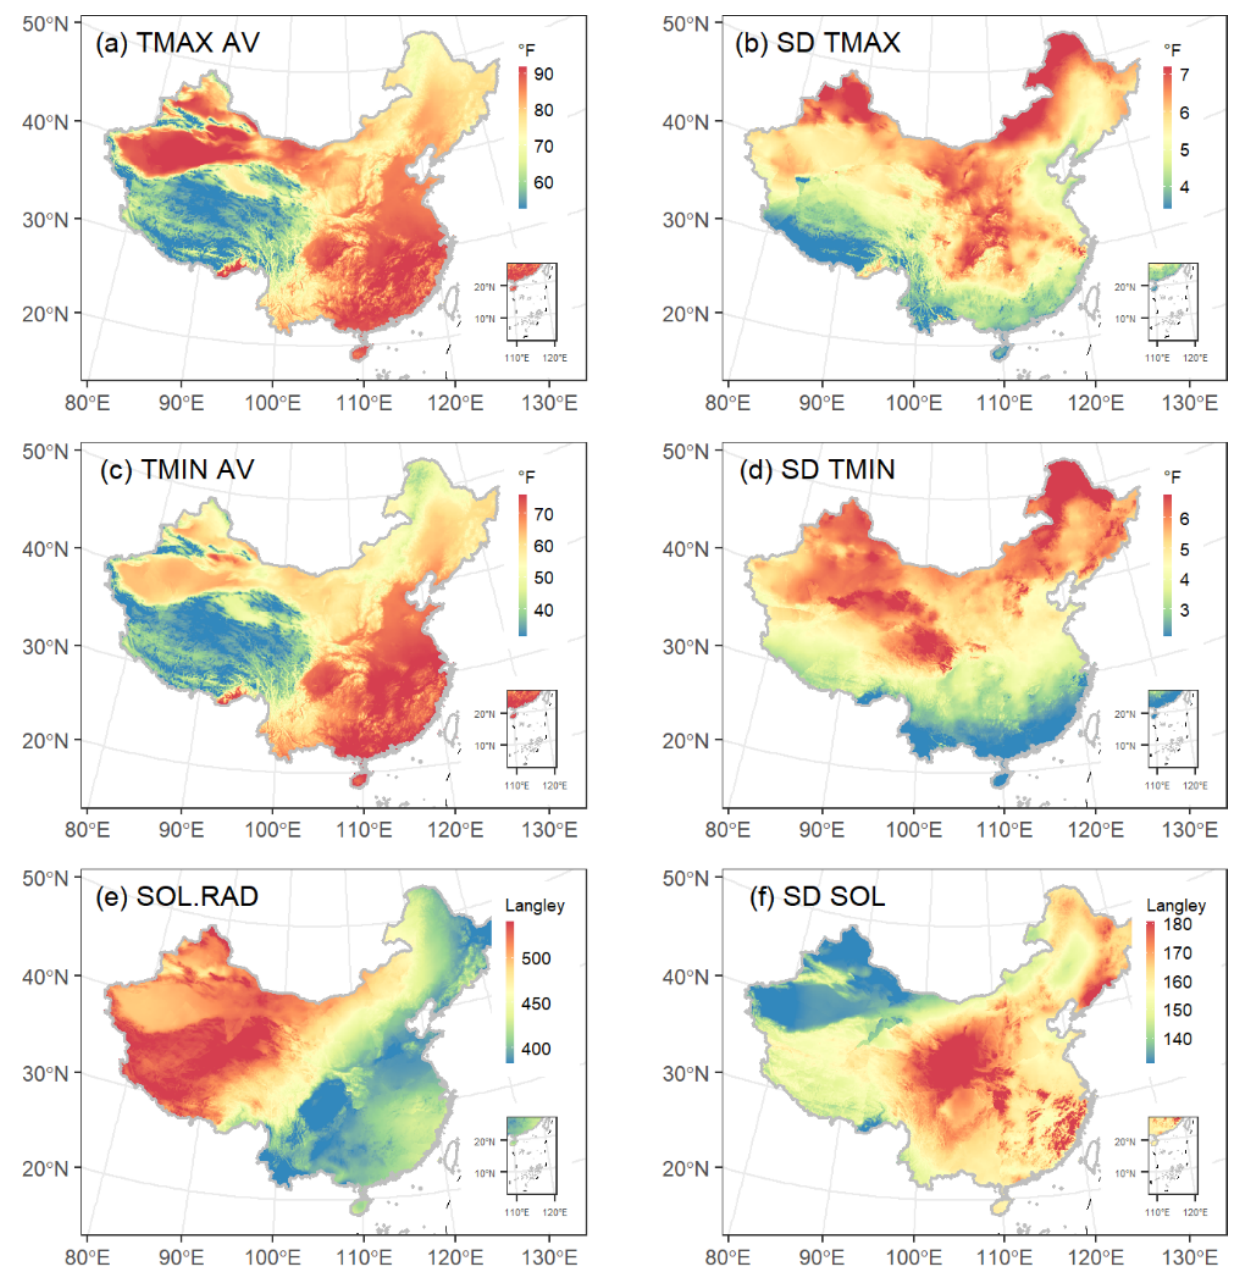
Figure 3. Map of the study area showing the spatial distribution of CLIGEN temperature-related parameters of mainland China in August. All parameters were regionalized using universal